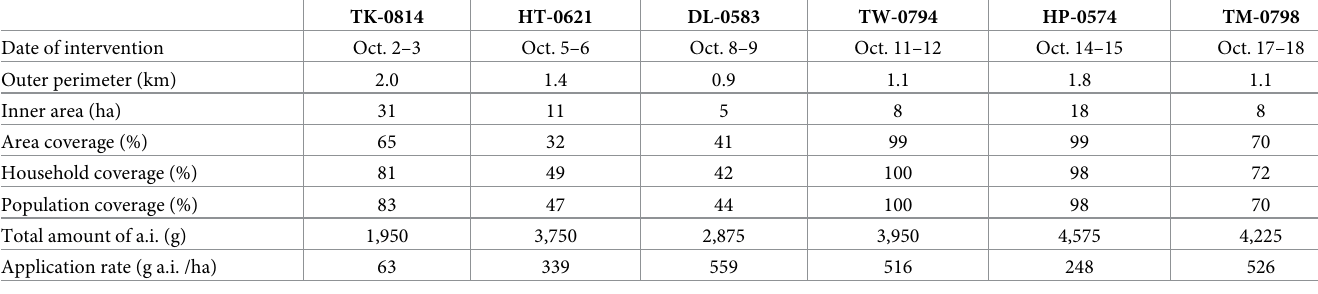
Table 2. Summary of the characteristics of ORS intervention by